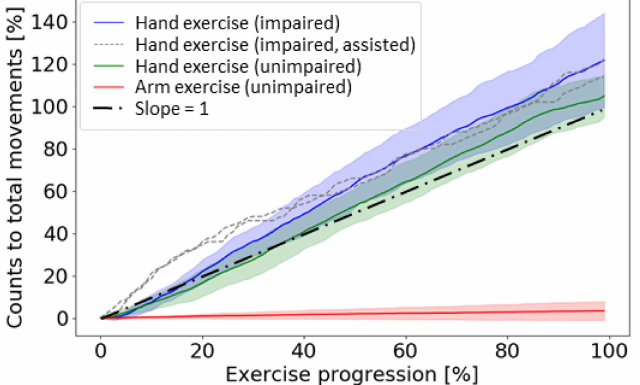
Figure 6. Hand counts for hand-only and arm-only exercises performed in the laboratory plotted as a function of exercise progression. Subjects were either impaired (due to hemiparesis after a stroke) or unimpaired. Two subjects in the impaired group could not perform the hand-only exercise without assistance of their unimpaired hand and are presented with the dashed lines. The impaired, assisted subjects had an average count accuracy of 82% for hand-only exercise. The remainder of the impaired subjects ( n = 7) performed the exercise without assistance and had an accuracy of 78% for the hand-only exercise. Unimpaired subjects ( n = 8) had a count accuracy of 95% for the hand-only exercise. Perfect counting for the hand-only exercise would be a line with a slope of 1. Only unimpaired subjects performed the arm-only exercise with 6% of crosstalk. Shaded areas show 1